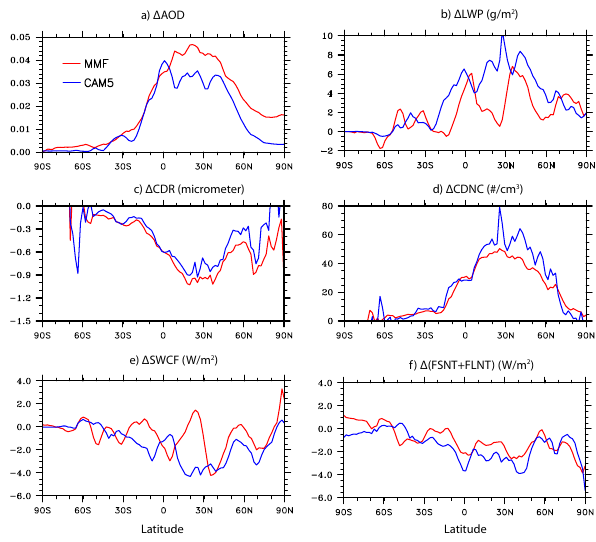
Fig. 13. Change in the zonal-mean annual-average (a) AOD, (b) liq- uid water path (LWP), (c) cloud top droplet effective radius (CDR), (d) cloud top droplet number concentrations (CDNC); (e) shortwave cloud forcing (SWCF); and (f) net total flux at the top of the at- mosphere (FSNT+FLNT) from anthropogenic aerosols in both the MMF (red lines) and CAM5 (blue lines)